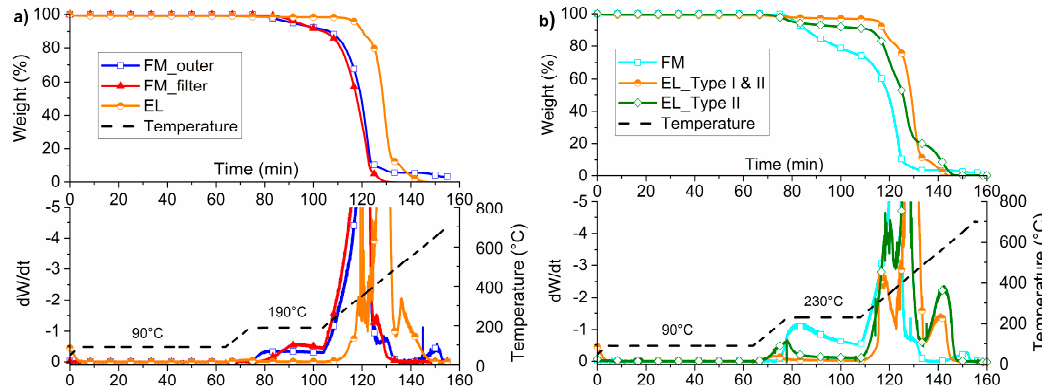
Figure 7. Thermogravimetric Analysis (TGA) of ( a ) FM_outer, FM_filter, and EL with processing simulation at 190 °C (weight % up/derivate down); ( b ) TGA of FM, EL_ Type I and II, and EL_Type II with processing simulation at 230 °C (weight % up/derivate down).